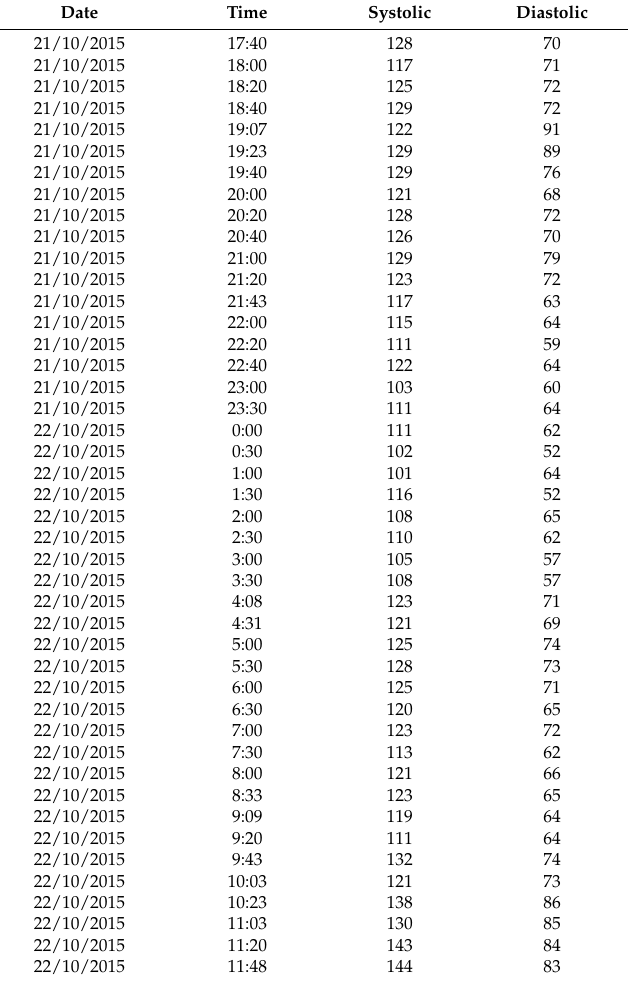
Table 3. Excel file given by the ambulatory monitoring